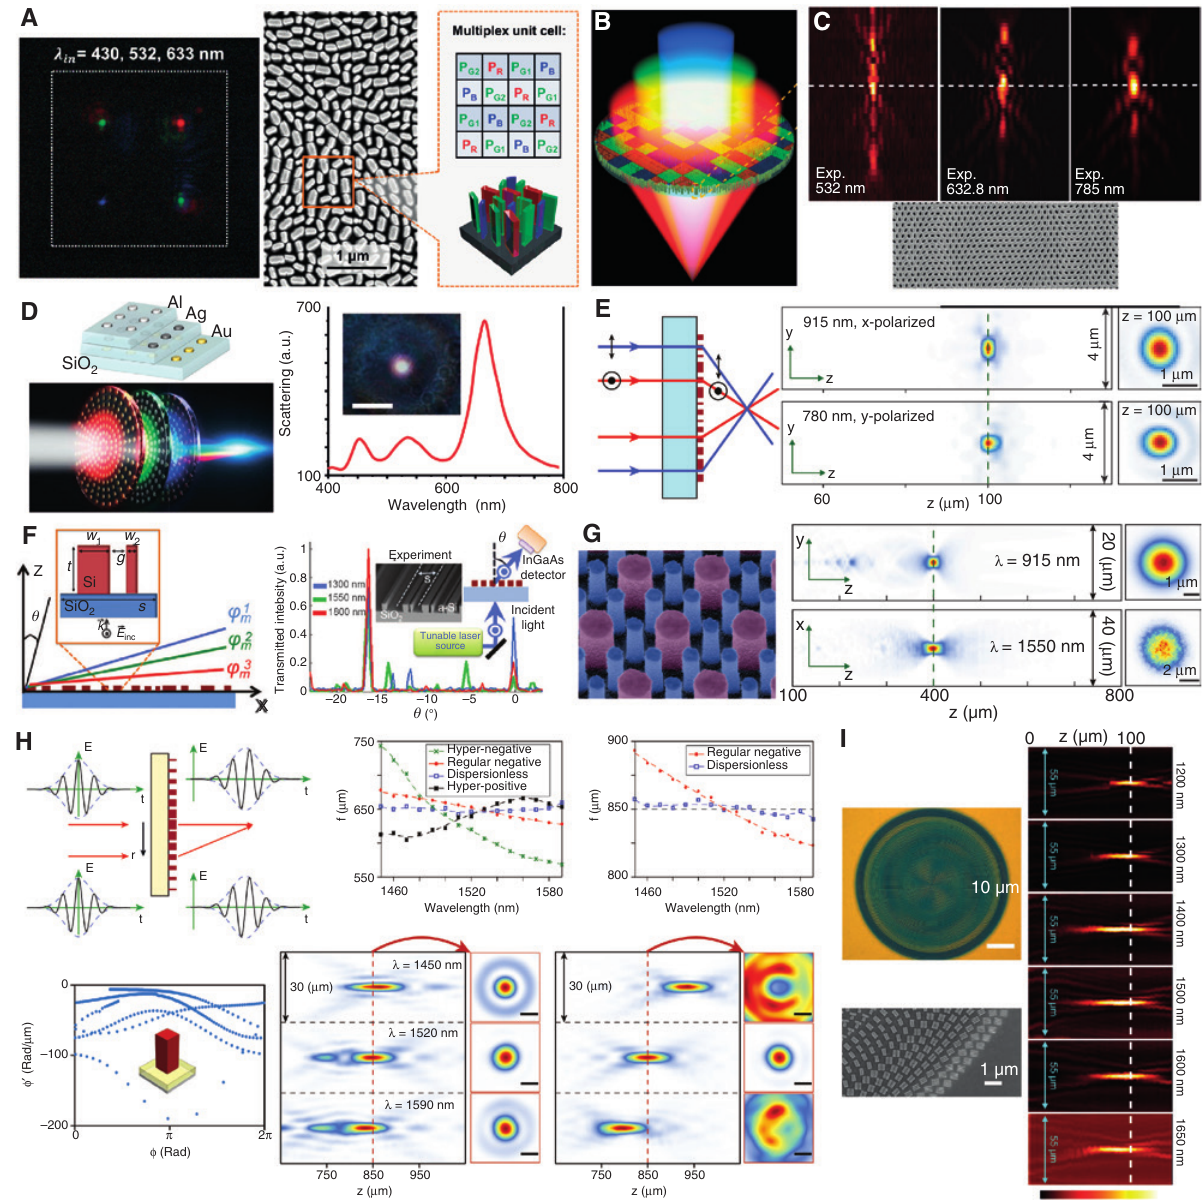
Figure 4: Multi-wavelength and dispersion-engineered metasurfaces. (A) An example of a spatially multiplexed multiwavelength metasurface through interleaving of GaN meta-atoms. Four lenses are mul- tiplexed to separate RGB colors [73]. (B) Concept of a multiwavelength metasurface lens multiplexed through segmentation [167]. (C) Multiwavelength metasurface lens designed through holographic superposition of fields [168]. (D) Multiwavelength Fresnel-zone-plate lens designed using frequency-dependent scatterers [169]. (E) Double-wavelength metasurfaces designed with birefringent meta-atoms [170]. (F) Multiwavelength metasurface grating designed with multiscatterer unit cells (meta-molecules) [171]. (G) Polarization insensitive multiwave- length lenses designed with dielectric meta-molecules [31]. (H) Dispersion-engineered metasurfaces designed using meta-atoms with inde- pendent control of phase and group delays. Focusing mirrors and gratings with inverse, zero, and increased dispersion are demonstrated [122]. (I) Achromatic lenses and gratings designed using plasmonic meta-atoms with varying phases and phase derivatives